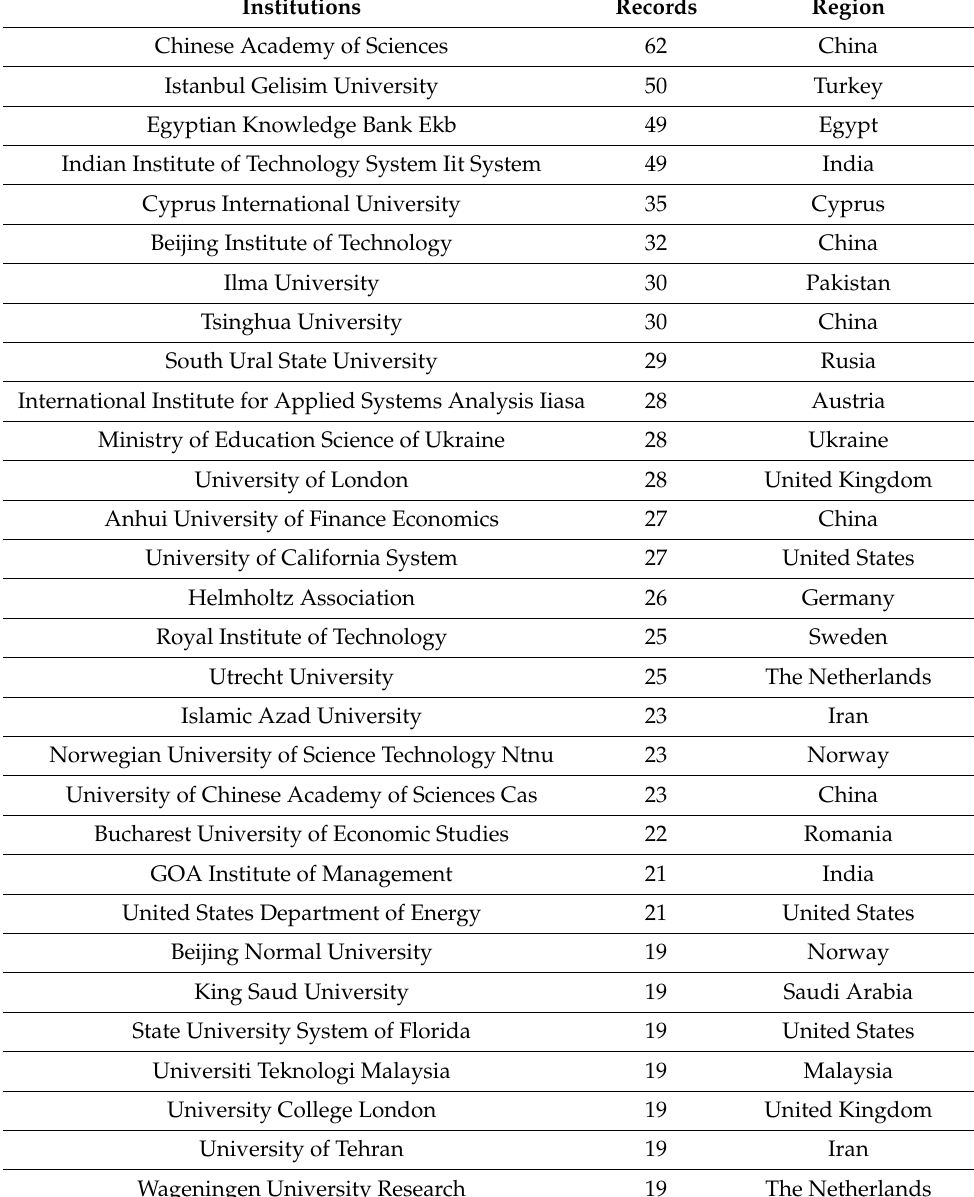
Table 4. Institutions by number of records and region